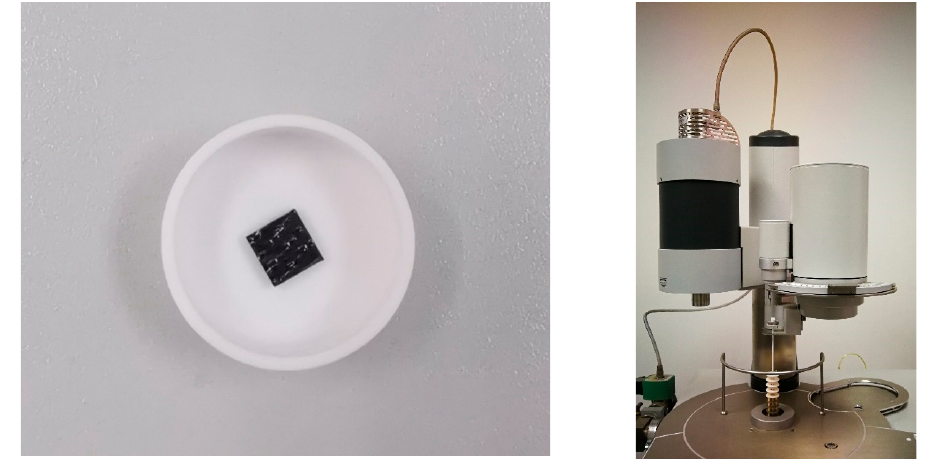
Figure 1. Specimen in the crucible and placement in the equipment. Thermal analysis experiments were performed using the simultaneous thermal ana- lyzer (NETZSCH STA 449 F3, NETZSCH, Selb, Germany), FTIR spectrometer (BRUKER VERTEX 80, BRUKER, Billerica, MA, USA) and mass spectrometry (NETZSCH QMS403C, NETZSCH, Selb, Germany) to investigate the mass changes (TG, Thermogravimetric), derivative of mass changes (DTG, Derivative Thermogravimetric) and gas composition (FTIR/MS), referring to the test standards [37–40]. The sample used in the simultaneous thermal analyzer was heated from room temperature to 1100 ◦ C at the heating rates of 5, 10, 20 and 40 ◦ C/min, under the atmosphere of air and inert gas, respectively, with the purge flow rate set to 20 mL/min. The primary aim of the TG analyses was to know the thermal degradation characteristics of materials, and to obtain adequate data to perform kinetic analysis in order to obtain the Arrhenius parameters. IR spectra were recorded in the spectral range of 4500–650 cm − 1 with a resolution of 4 cm − 1 and an average number of scans of 16. The intensities of 17 ions ( m / z = 14, 16, 17, 18, 26, 28, 30, 42, 44, 46, 56, 60, 64 and 94) were determined according to the previous work